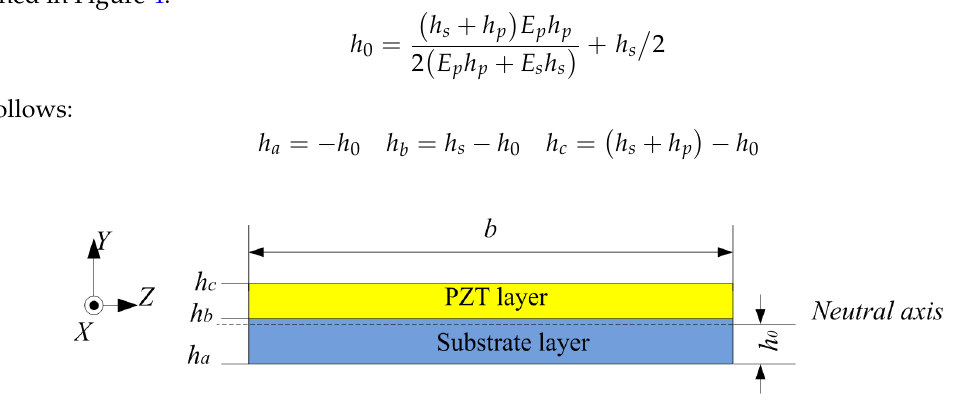
Figure 4. The neutral axis.